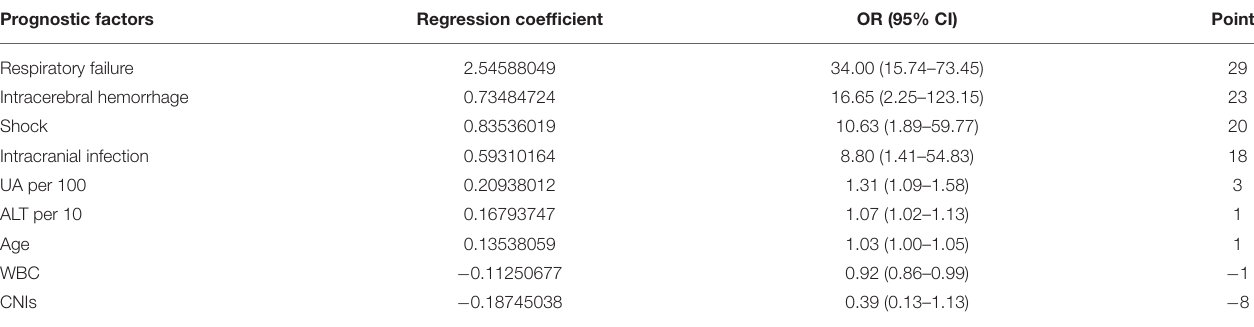
TABLE 6 | Prognostic model to predict in-ICU mortality based on derivation